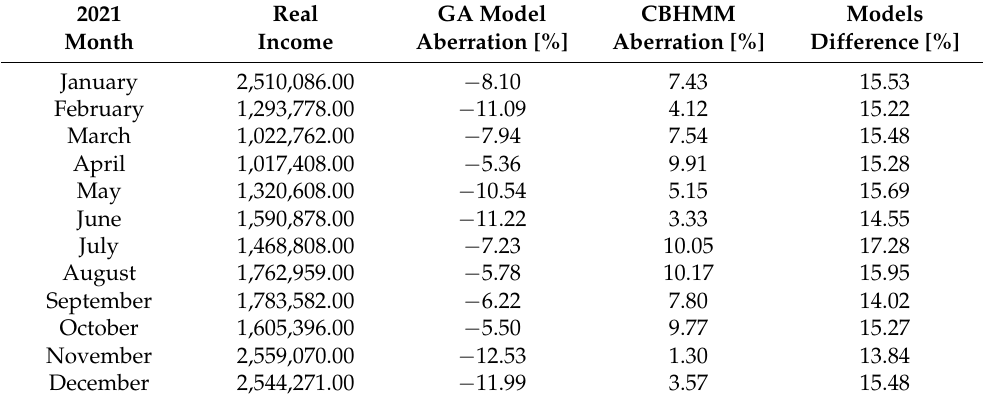
Figure 4. Prediction of income using the CBHMM and GA models, in comparison to real income for the year 2021. Table 1. Real income and aberration in prediction of income using the GA model and CBHMM for the year 2021.